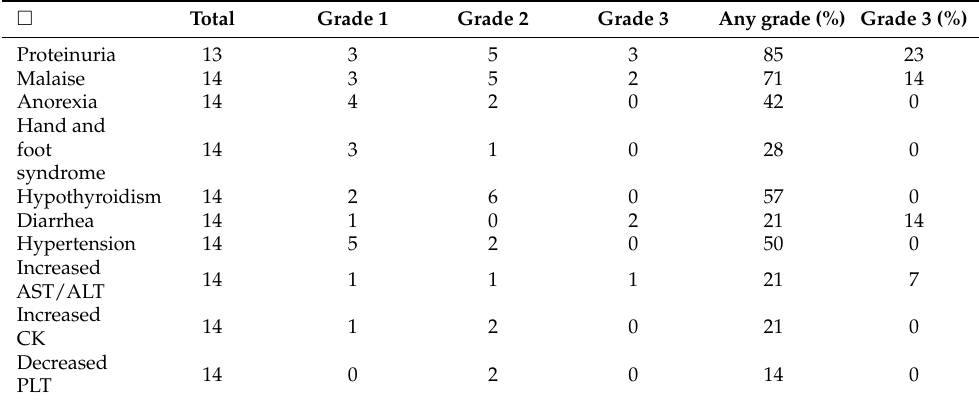
Table 3. Adverse events in any grade during cabozantinib